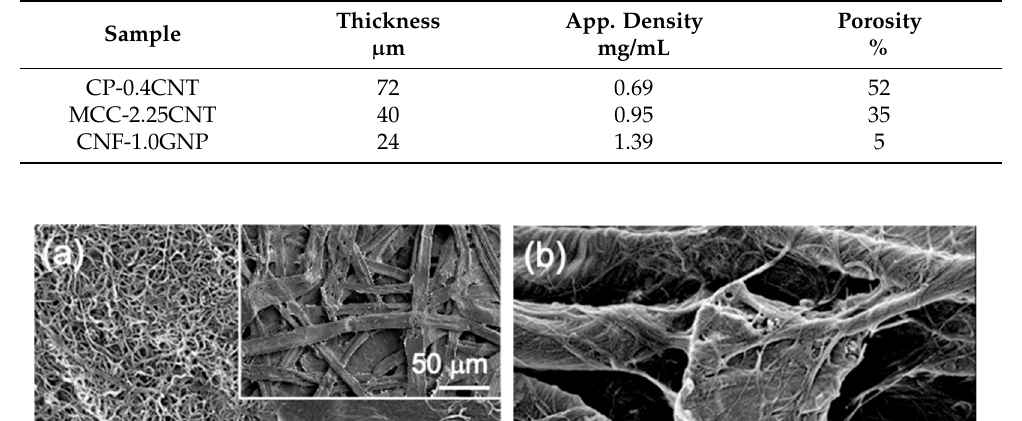
Table 1. Textural properties of nanocomposite films.